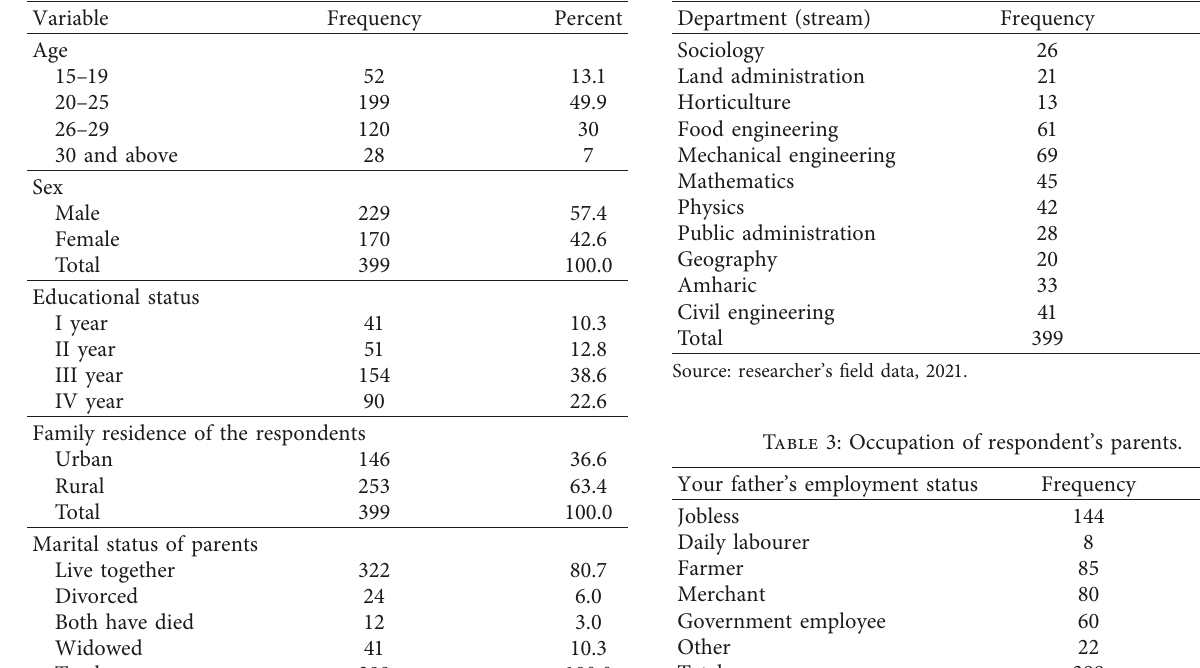
Table 1: Demographic characteristics of respondents. Table 2: Departments of respondents.